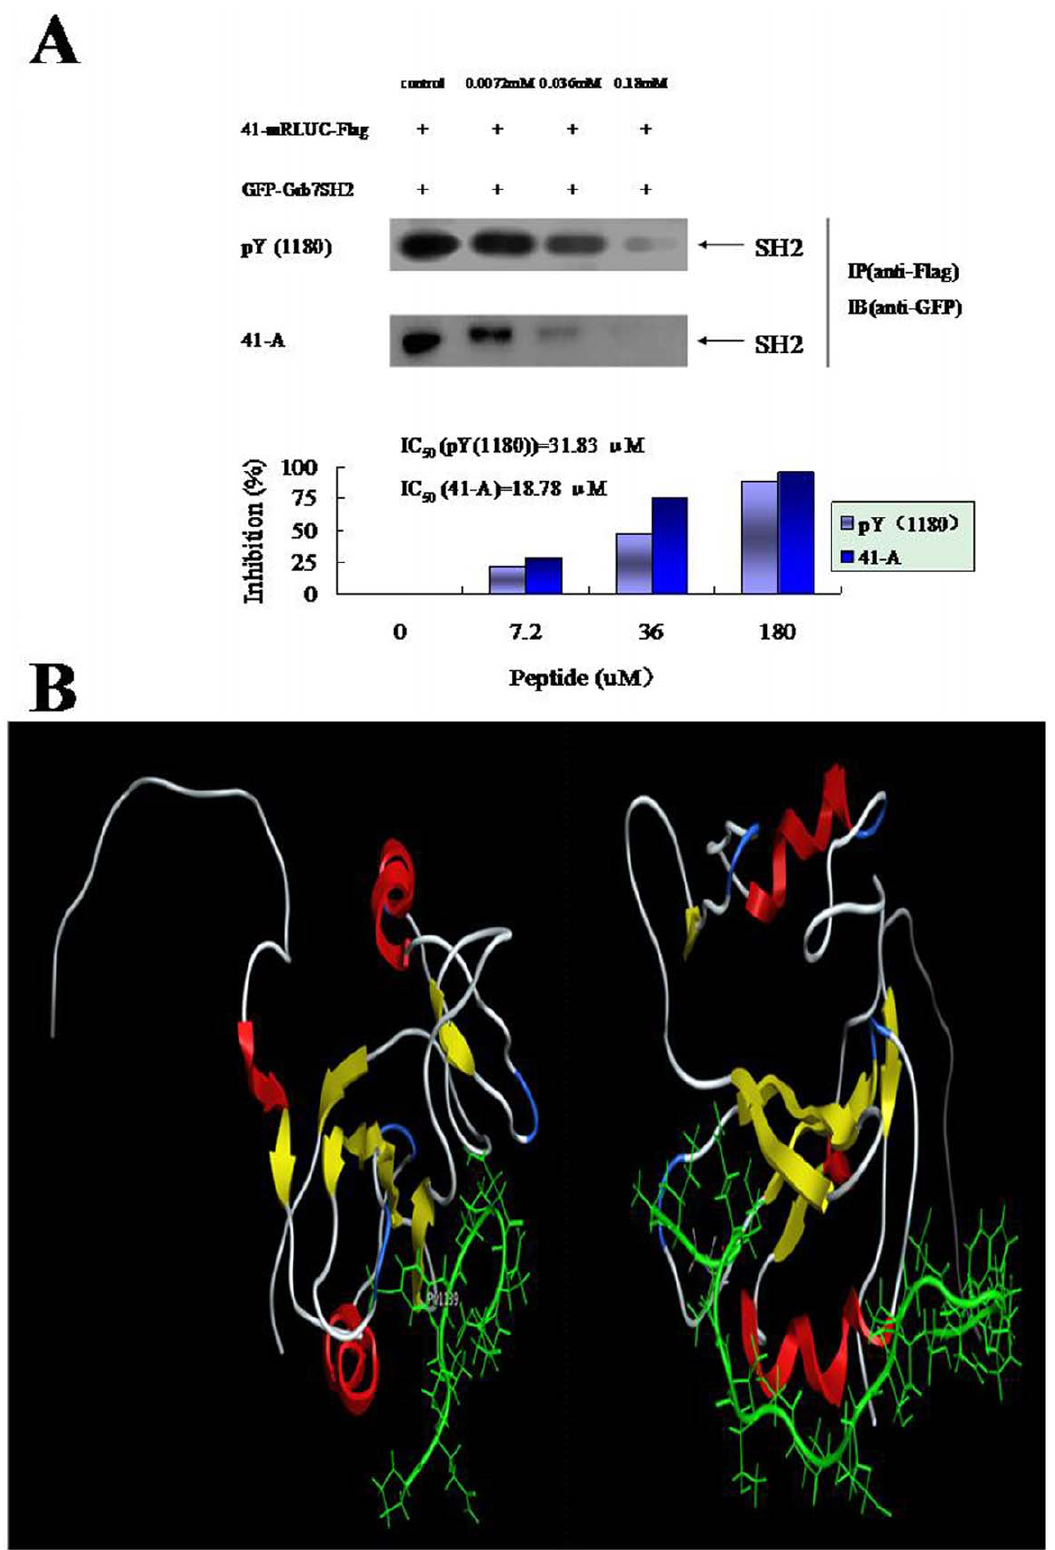
Figure 3. The nonphosphorylated peptide has at least comparable binding affinity to the phosphorylated ligand pY (1180) for the Grb7 SH2 domain. A ) Different concentrations of synthesized phosphorylated ligands pY (1180) (DEEYEpY(1180)MNRRR) from ErbB3 and the nonphosphorylated ligands 41-A (VAVGIPTQPTTSSEPSPPSNPPWDPGRV) from the nonphosphorylated ligand 41 were added respectively into the interacting complexes of Grb7 SH2 domain and peptide 41 (on the top). The bands were scanned and IC 50 values were calculated (on the bottom). B )